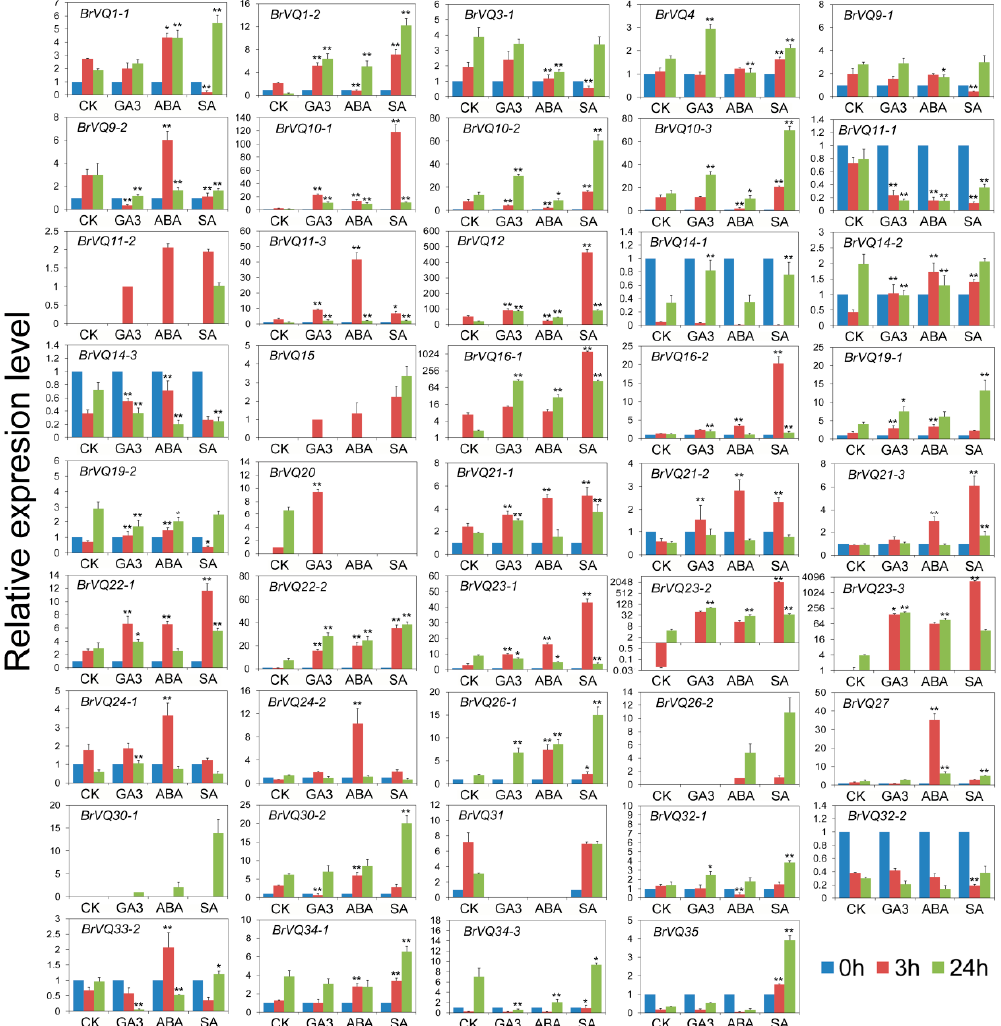
Figure 9. Expression analysis of the BrVQ genes under phytohormones. Three-week-old plants were treated with 200 μ M GA 3 , 100 μ M ABA, and 200 μ M SA for 0, 3, and 24 h before the mature leaves were harvested. Expression of the BrVQ genes were normalized to those of BrActin and shown relative to the expression of CK at 0 h, except for five BrVQ genes ( 11-2 , 15 , 20 , 26-2 , 30-1 ), whose expression levels were related to the expression of CK treated with GA 3 , GA 3 , CK, ABA at 3 h, and GA 3 at 24 h, respectively. The 2 −ΔΔ Ct method was used to calculate the expression of target genes in different tissues. The expression levels of three BrVQ genes ( 16-1 , 23-2 , 23-3 ) are shown by log2. * indicated that the expression level is significantly different from the value of the control (* p < 0.05, ** p < 0.01).